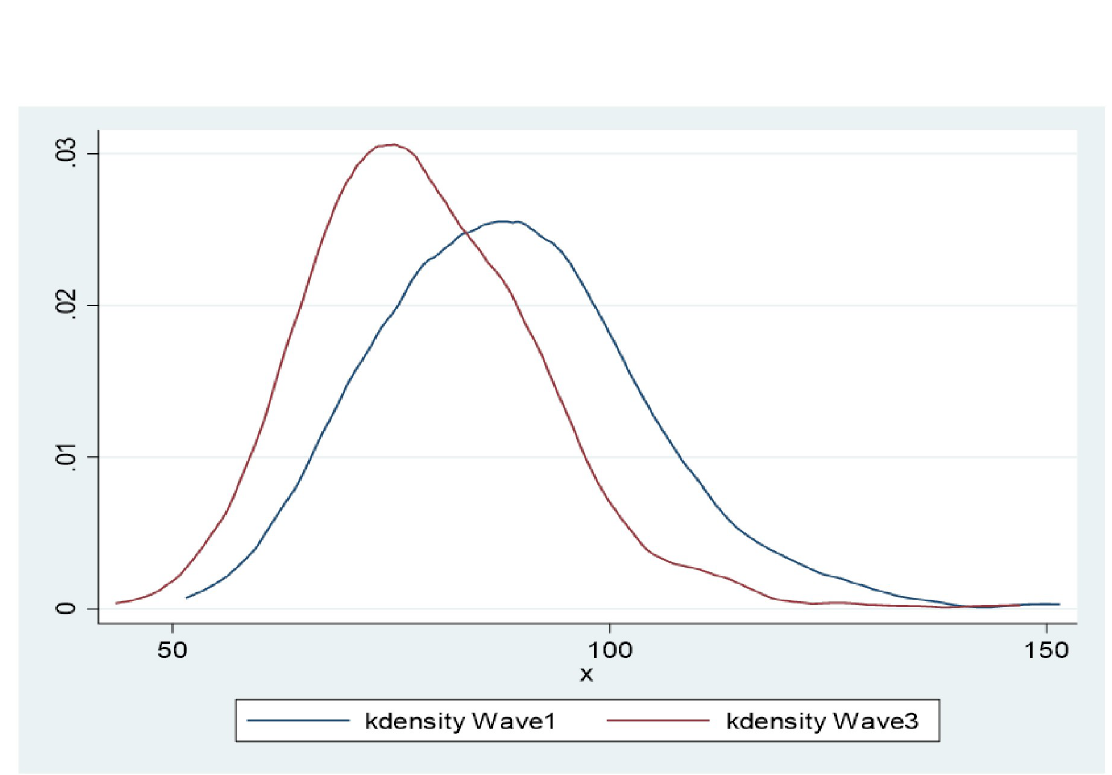
Fig 3. Non-parametric kernel-density estimates for the distribution of DBP (W1, W3 n = 820).